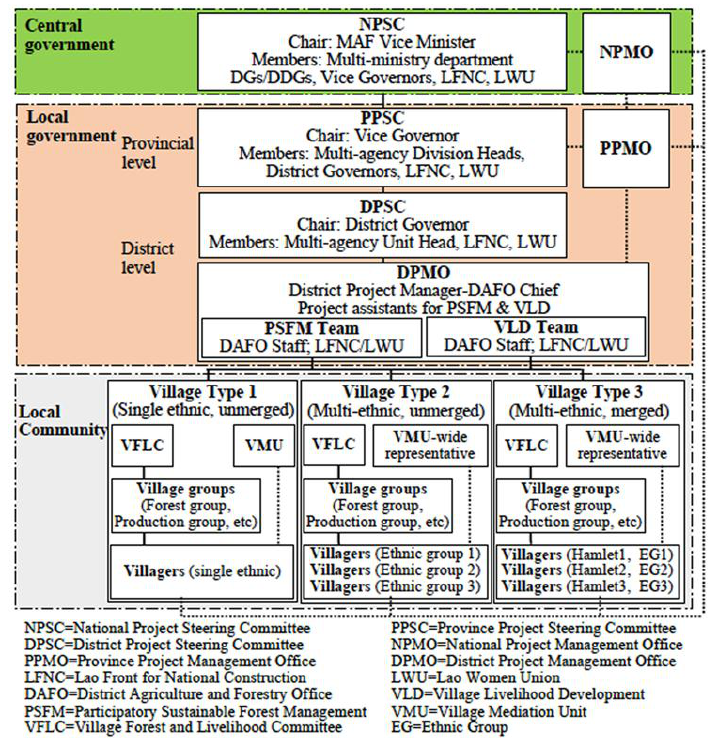
Figure 3. Institutional structure of SUFORD-SU. Source: adapted from annual working plan [43].